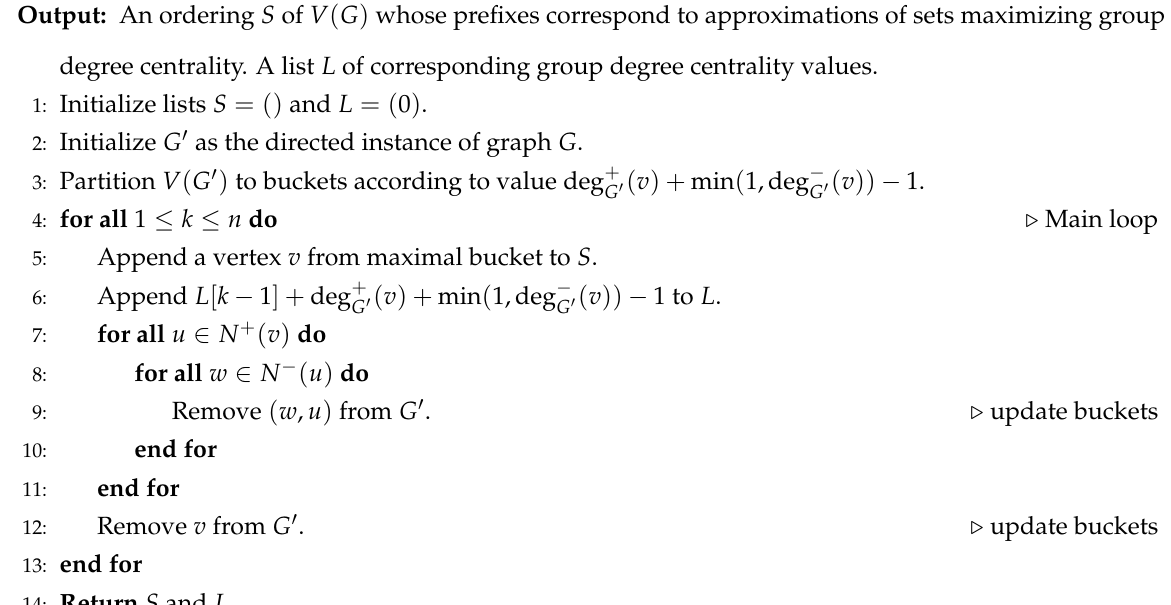
Algorithm 2 Greedy approach to finding a group with the maximum degree